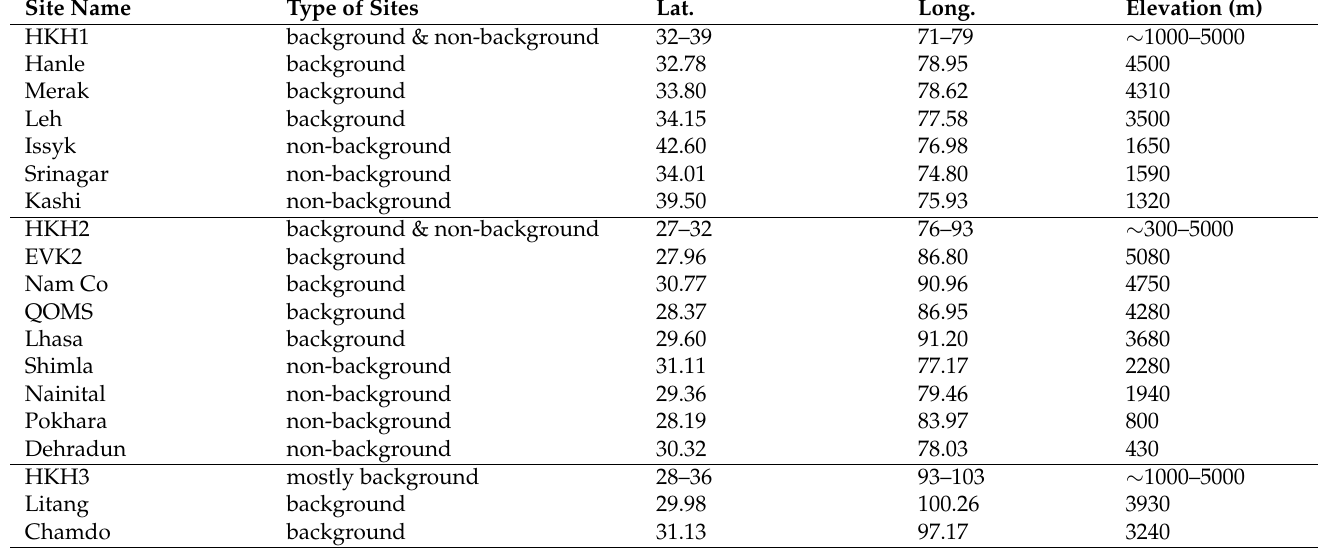
Table 1. Stations located in the HKH region as well as the three sub-regions of HKH considered in the present study for AOD trend